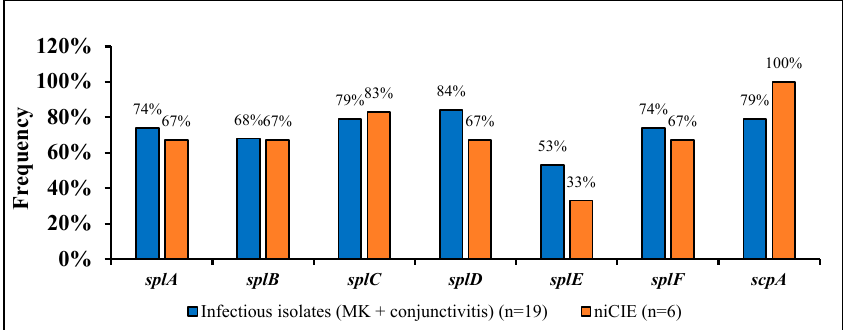
Figure 2. Frequency of 7 proteases in S. aureus by disease group. Similarly, the frequency of protease genes in strains isolated from MK or conjunctivitis was not significantly different, although conjunctivitis strains (100%) had a trend for more frequent presence of splA ( p = 0.1) and splF ( p = 0.1) than MK strains (58%). In infectious isolates (MK + conjunctivitis) from the USA, possession of splC (100% vs. 55%; p = 0.03) and splB (90% vs. 44%; p = 0.05) was higher and there was also a trend for higher possession of splD (100% vs. 66%; p = 0.08) and splA (100% vs. 55%; p = 0.1) compared to Australian isolates, except scpA (100% vs. 60%; p = 0.08) which was higher in infectious isolates (MK + conjunctivitis) from Australia.